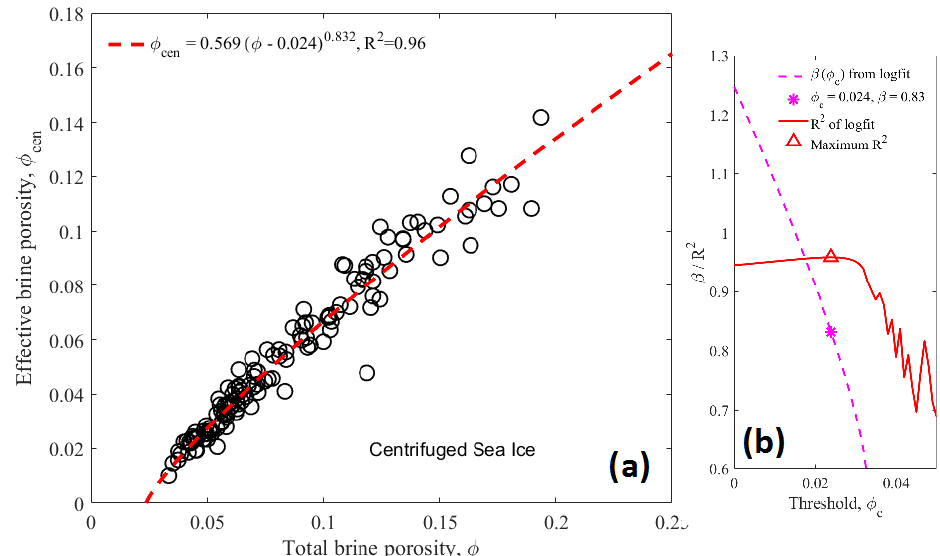
Figure 4. (a) Relationship between centrifuged brine porosity φ cen and total brine porosity φ based on 3–4cm thick samples from 15 young ice cores of 35cm length. (b) Optimum exponent β in dependence on porosity threshold φ c and the R 2 of double-logarithmic least-squares fits of φ cen versus (φ − φ c ) β . The point of maximum correlation is shown as a